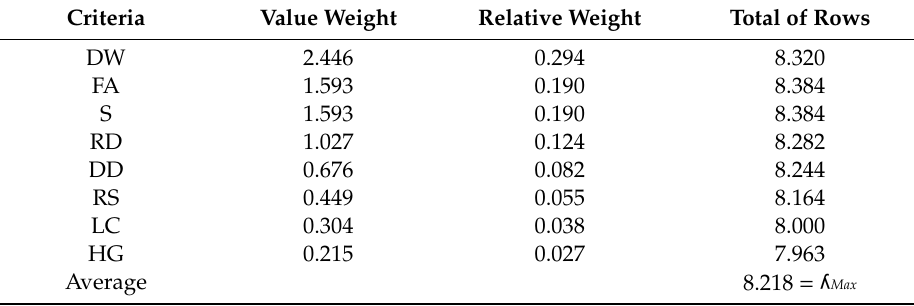
Table 8. Weight values of each criteria using AHP.